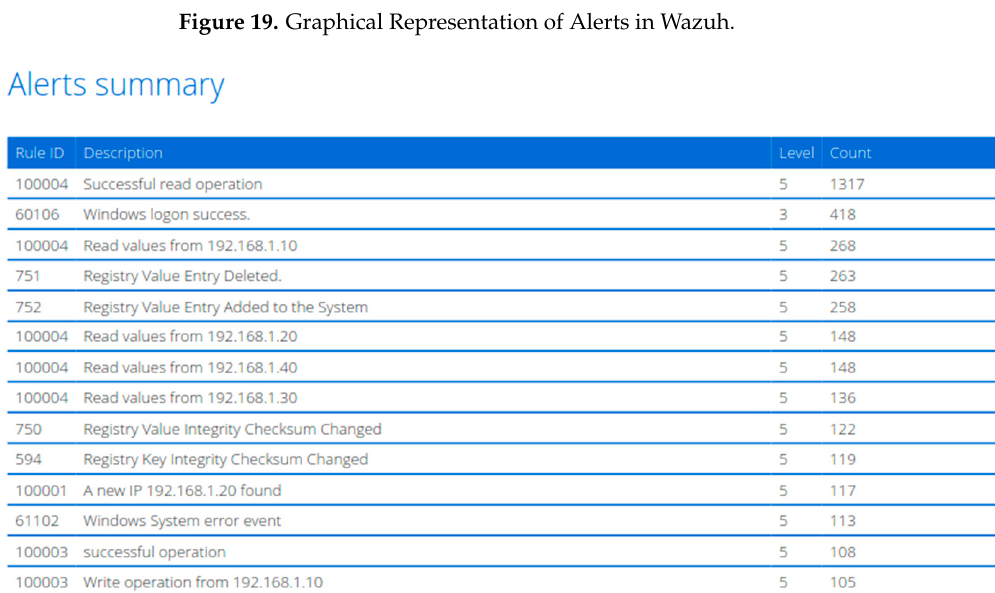
Figure 20. Alerts Summary.